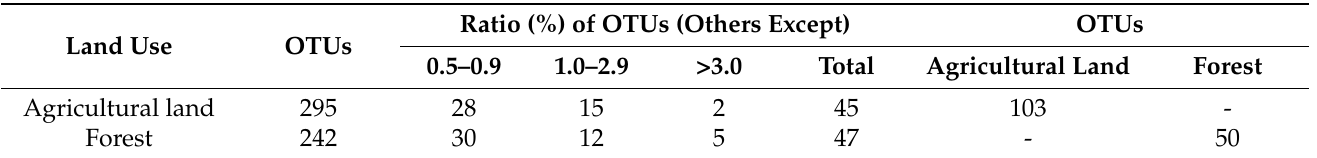
Table 3. Operational taxonomic units (OTUs) of ratio (%) of agriculture land and forest soils.